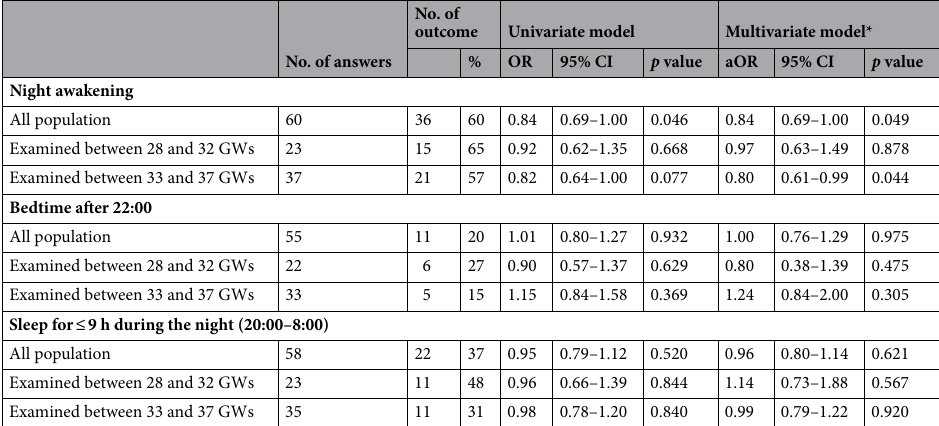
Association between fetal EMD and infant sleep problems. The numbers and proportions of cases with each sleep outcome are as follows: 36 cases (60%) with night awakening, 11 cases (20%) with a bedtime after 22:00, and 22 cases (37%) with nighttime sleep duration of ≤ 9 h (Table 2).